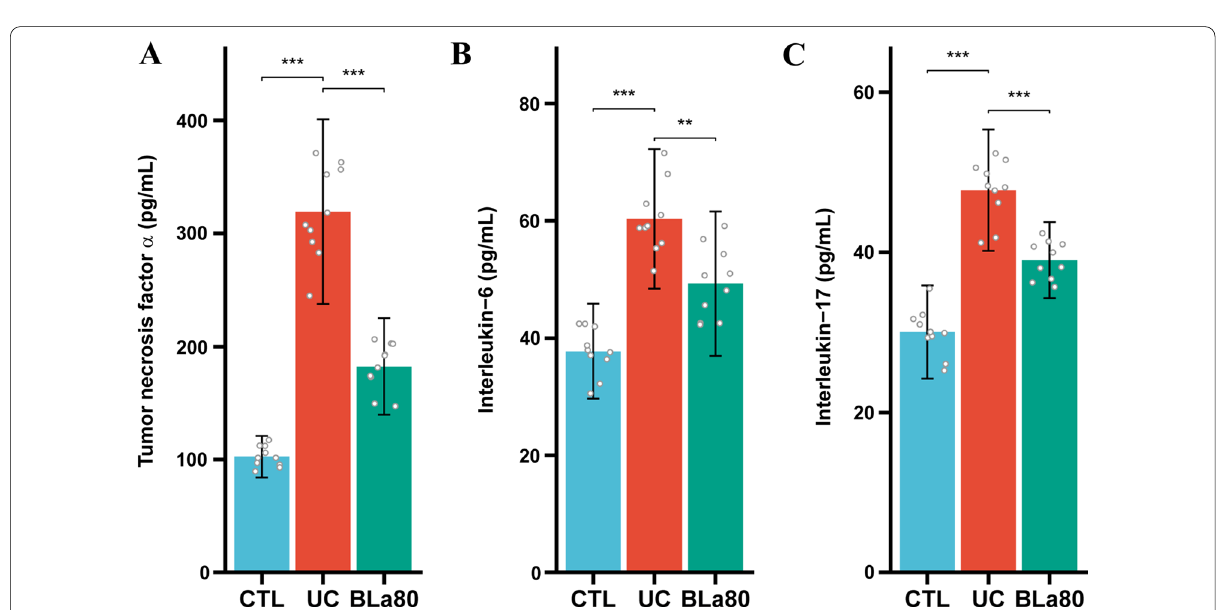
Fig. 2 Effect of Bla80 on serum cytokine levels in mice. A serum tumor necrosis factor α (TNFα) level in mice; B serum Interleukin (IL) 6 level in mice; C serum IL17 level in mice. Compared with the model group, BLa80 significantly decreased the serum levels of TNFα, IL6 and